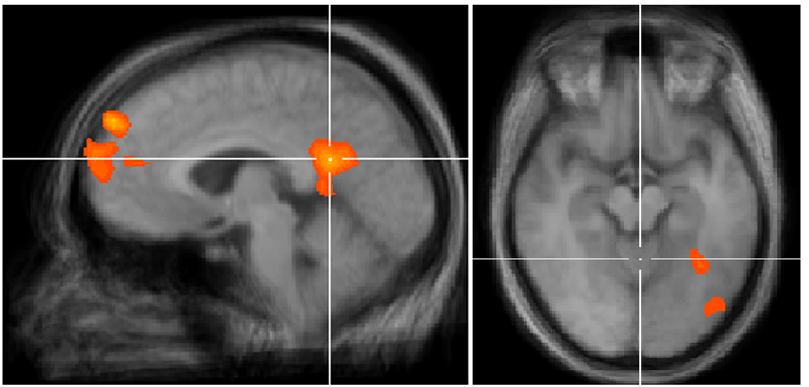
Figure 2. Examples of activation in the main contrasts. A. Comparison of activation during beauty versus roughness judgments shows signal increase in the frontomedian and posterior cingulate cortices. B. Comparison of activation for beautiful versus ugly stimuli shows signal increase in two clusters in the fusiform gyrus. Activation is presented for p , .001, uncorrected for multiple comparisons.